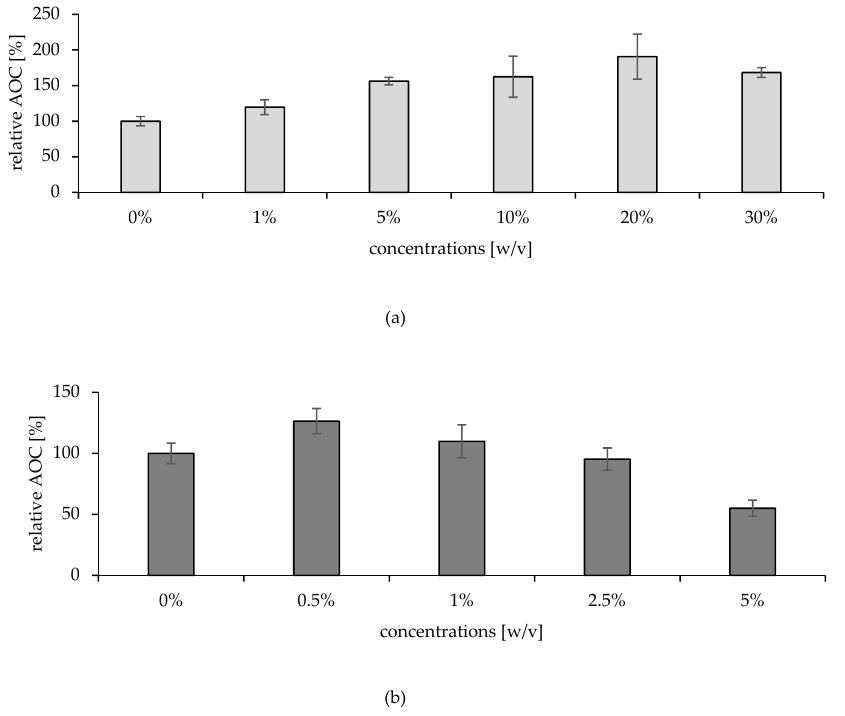
Figure 9. Relative AOC of the treated skin with ( a ) 1–30% (w/v) AA solutions ( p = 0.0443), and ( b ) 0.5–5% (w/v) CoQ10 ( p = 0.0001), compared to untreated skin. Detailed assessment was performed for further understanding of the results, i.e., the AOC of 10 layers of the SC was analysed separately after treatment with AA and CoQ10 high doses. The AOC values are shown in Figure 10 and revealed different behaviours for each antioxidant compared to the untreated skin. The AOC enhancement that resulted from AA was limited to the upper SC layers in line with its known poor penetration pro- file. On the contrary, the negative influence of CoQ10 was found to be extended to the deeper layers of SC.